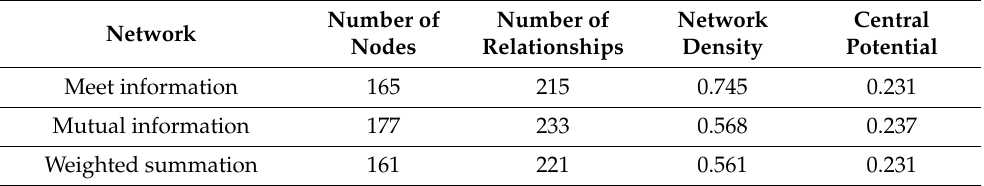
Table 2. Structure analysis of intelligent transportation logistics network.